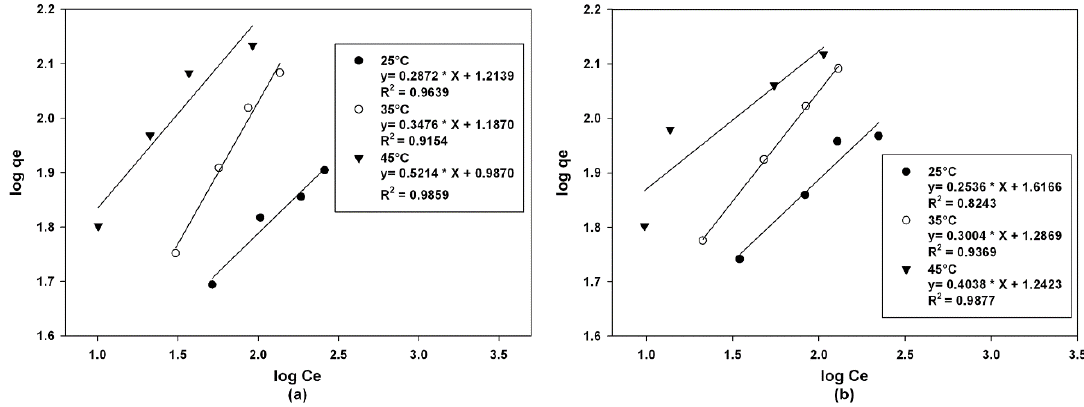
Figure 5. The Freundlich isotherm of gold onto (a) ARH and (b) L-214 (30 mg sorbent, 60 min, 100 rpm, pH=6.1, 10 mL sol. at a concentration of 200–500 mg/L).